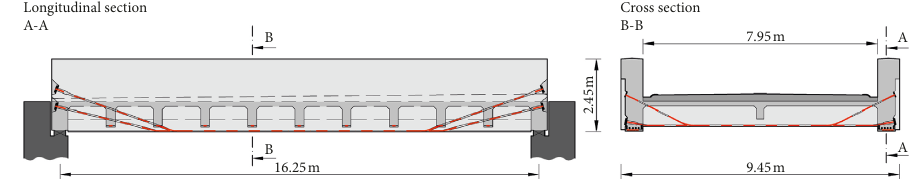
Figure 6: Cable arrangement in the longitudinal and transverse directions for strengthening of a U-shaped bridge with straight girders, built in Tˇrebechovice in 1932, according to project documentation [21].